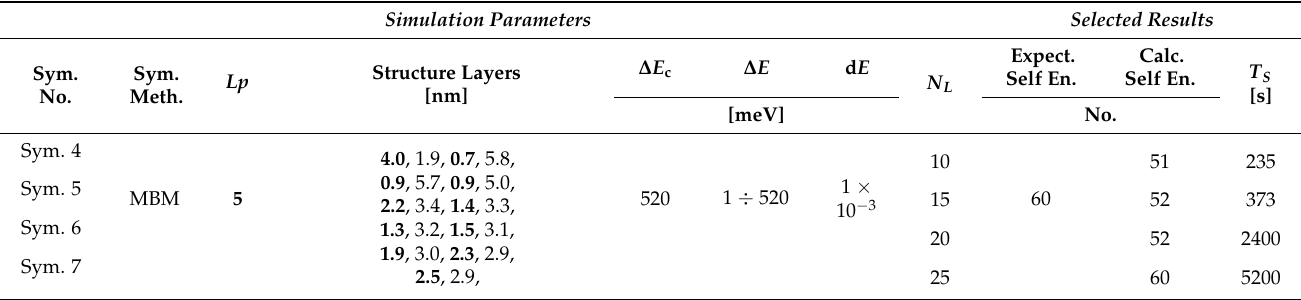
Table 4. Basic parameters and selected simulations results for structure presented in [3]. Simulation Parameters Selected